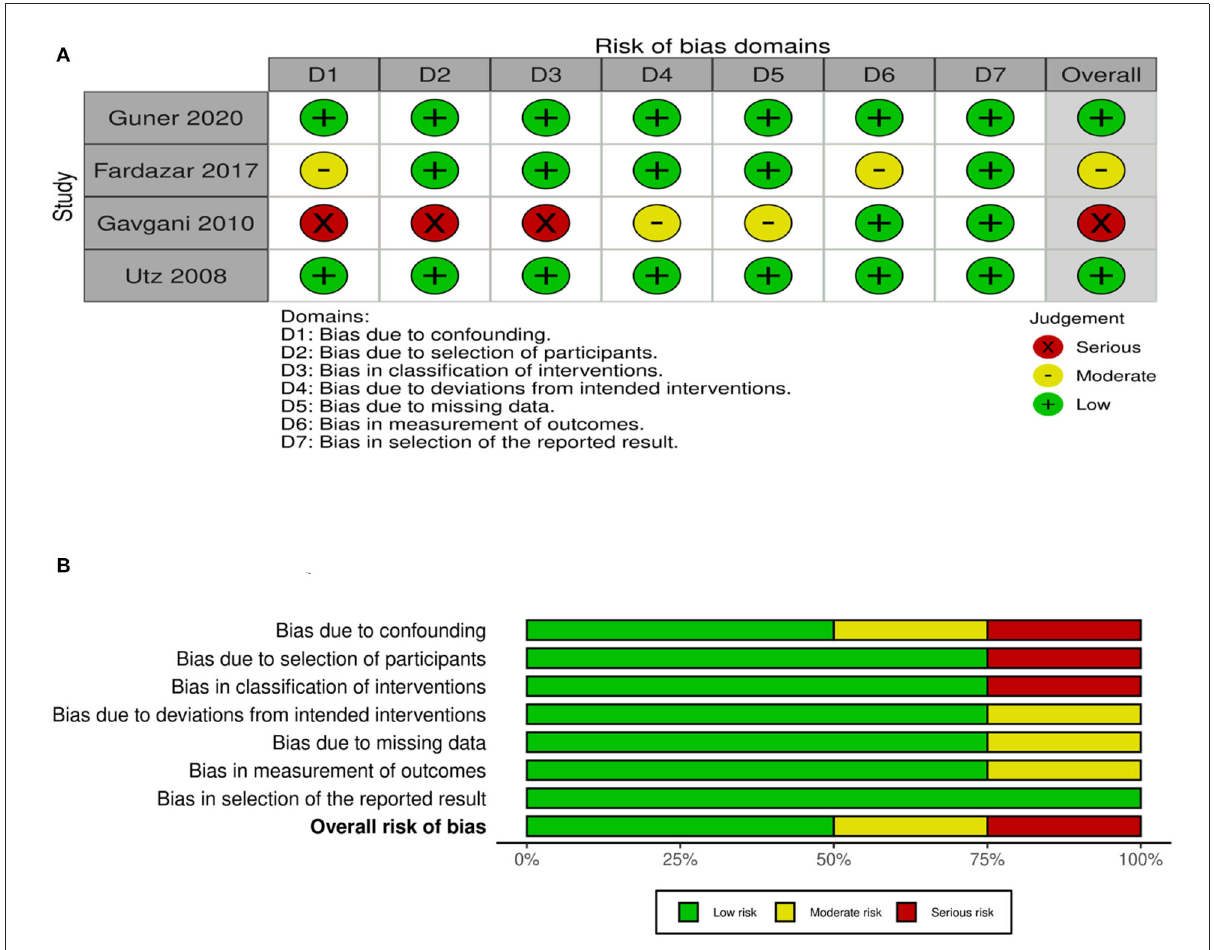
FIGURE3 (A) Quality of QESs assessed by using ROBINS-1. (B) Risk of bias summary